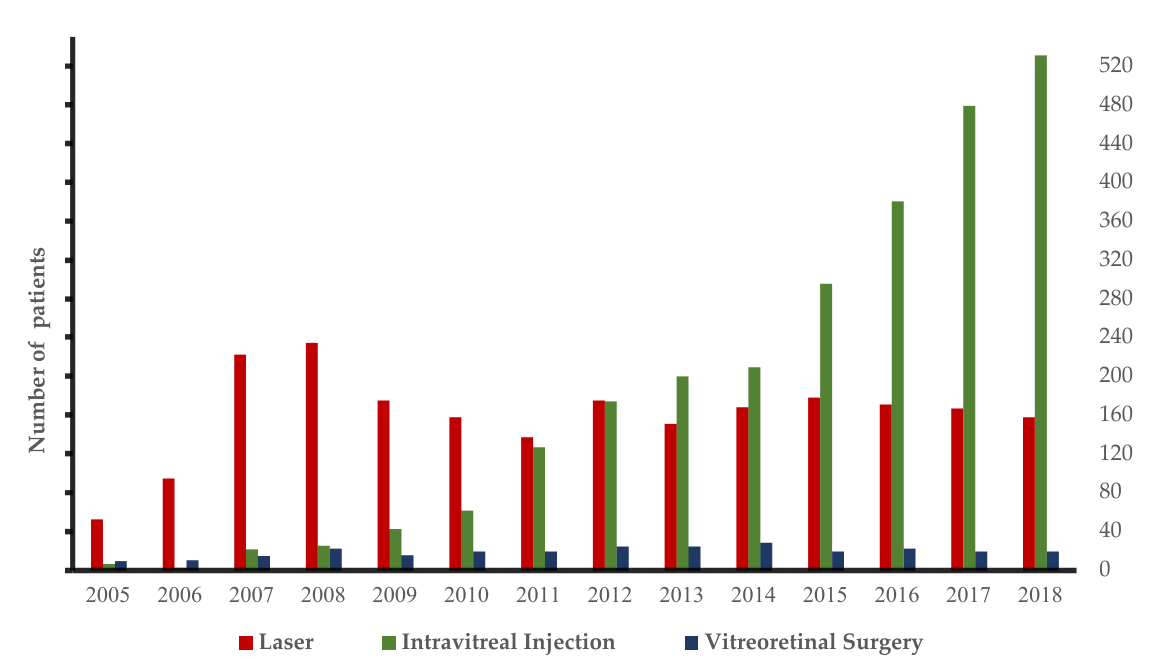
Figure A1. Number of treated patients per year receiving intravitreal injection, laser or vitreoretinal surgery (2005–2018).